Question: Which visualization type does this figure use?
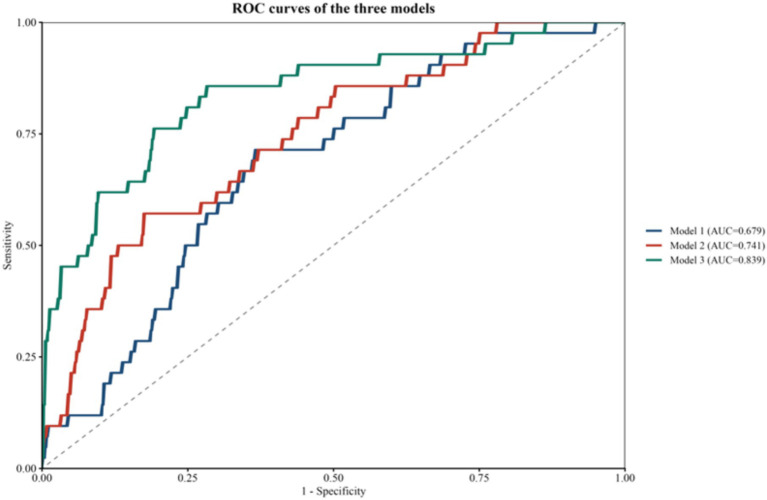
Answer: line